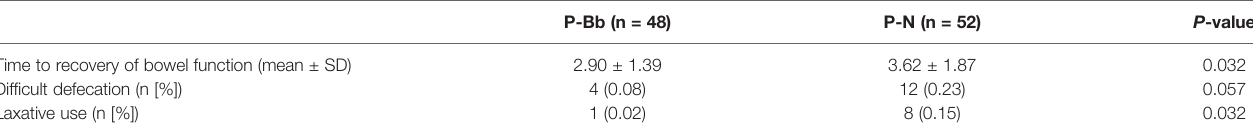
TABLE 3 | Postoperative bowel